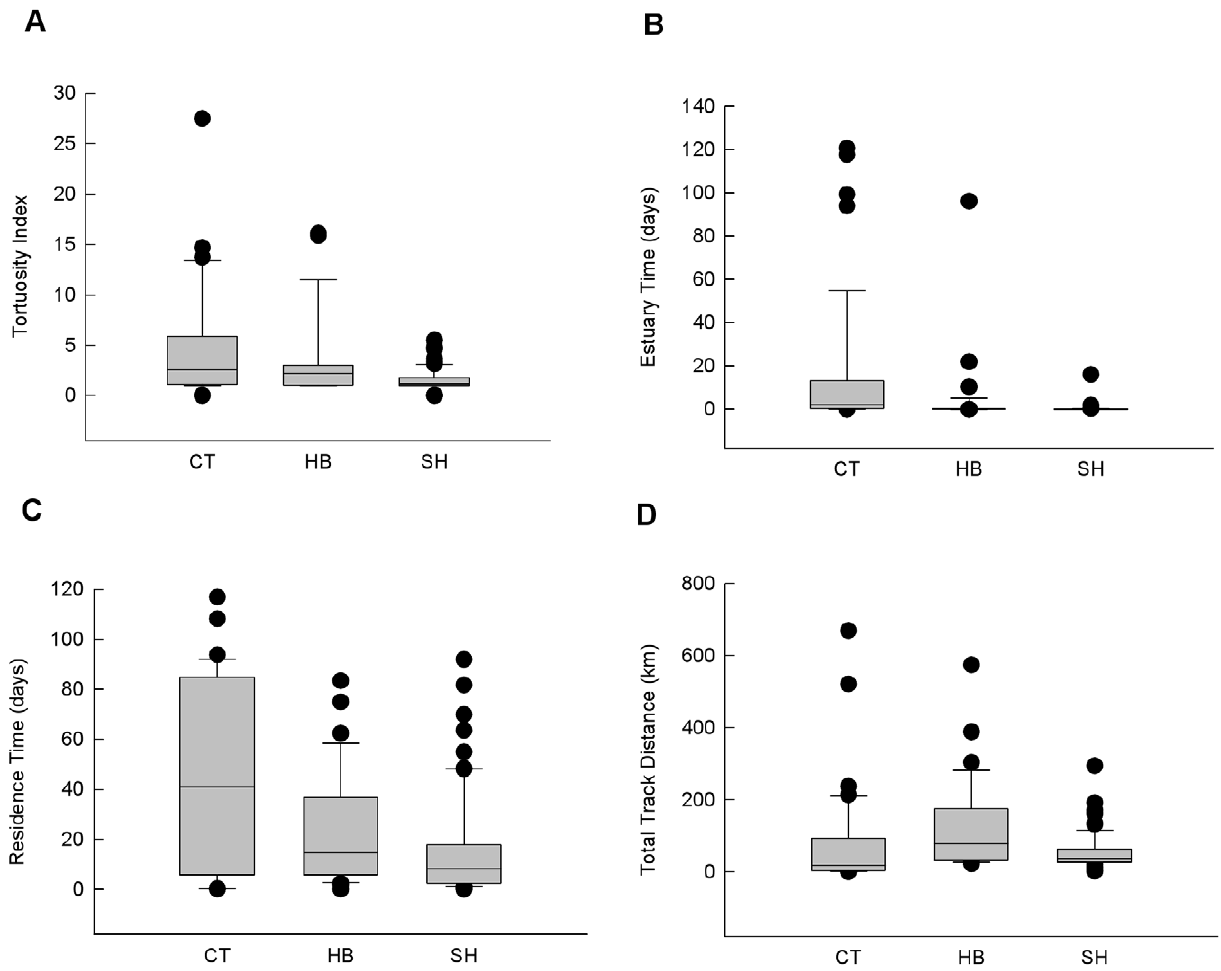
Figure 3. Box and whisker plots (median, interquartile range, data range, outliers) of migratory track parameters. (A) residence time (days), the time between ocean entry and last detection, (B) estuary time (days), the time between first and last estuary detection, (C) total track distance (kilometers), the sum of all track segments, and (D) the tortuosity index, which measures the extent to which a track meanders, and is the sum of all track segments divided by the linear distance between the two farthest receivers included in the track.